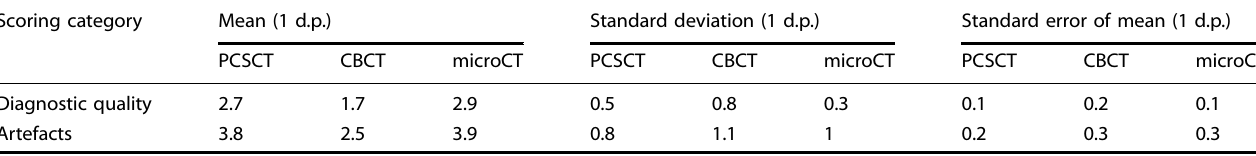
Table 5. Results from the statistical analysis, for the two different scoring categories, for PCSCT, CBCT and microCT. Scoring category